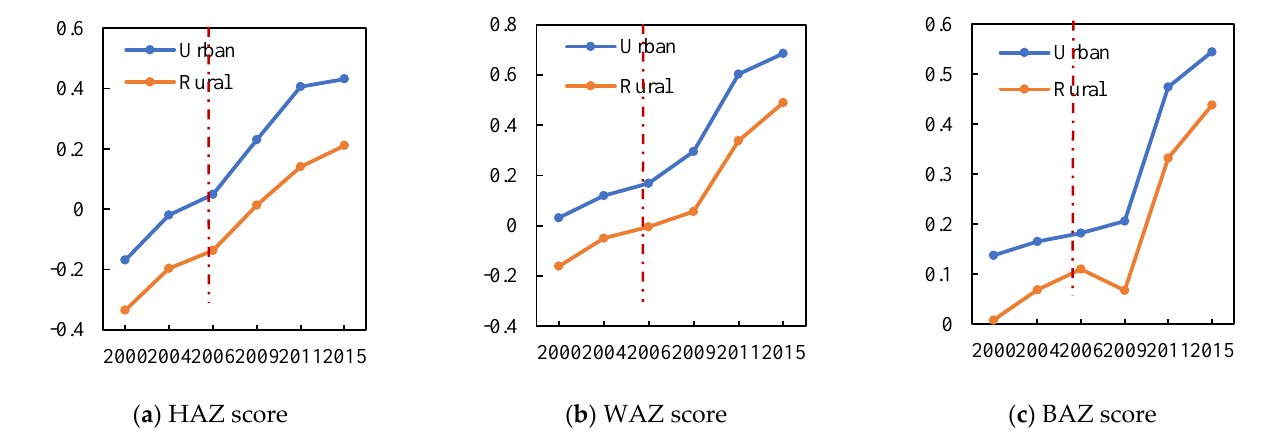
Figure 5. Child health status changes after the HAGC policy.